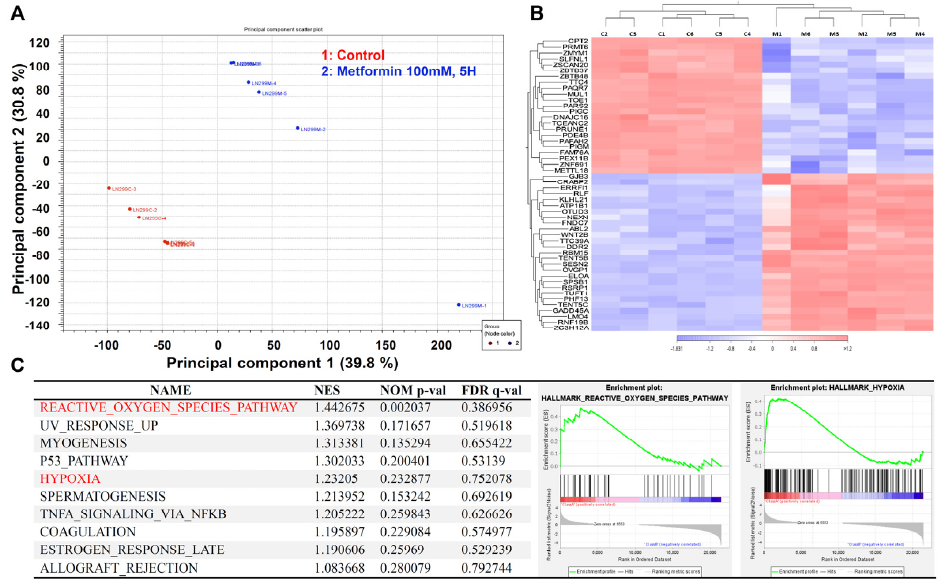
Figure 4. The effect of metformin on the transcriptome of LN229 cells. LN229 cells were treated with vehicle or 100 mM metformin for 5 h. Total RNA was extracted for RNA sequencing analysis. ( A ) PCA revealing different clusters of metformin-treated and control cells. ( B ) Heatmap showing the top differentially expressed genes in both groups. ( C ) GSEA study highlighting the increase in ROS and hypoxia in metformin-treated LN229 cells.